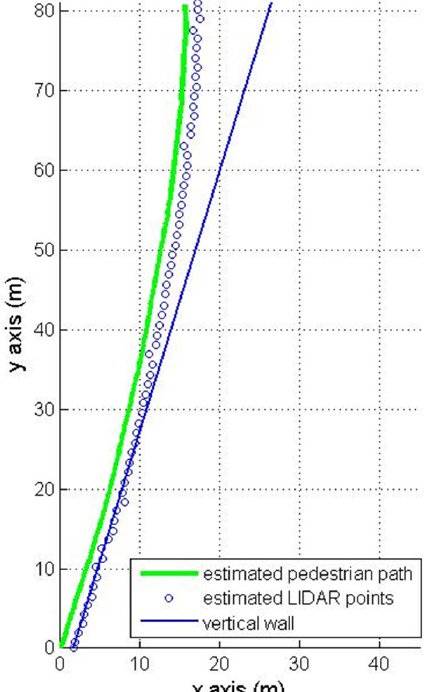
Figure 8. Pedestrian path using a pure